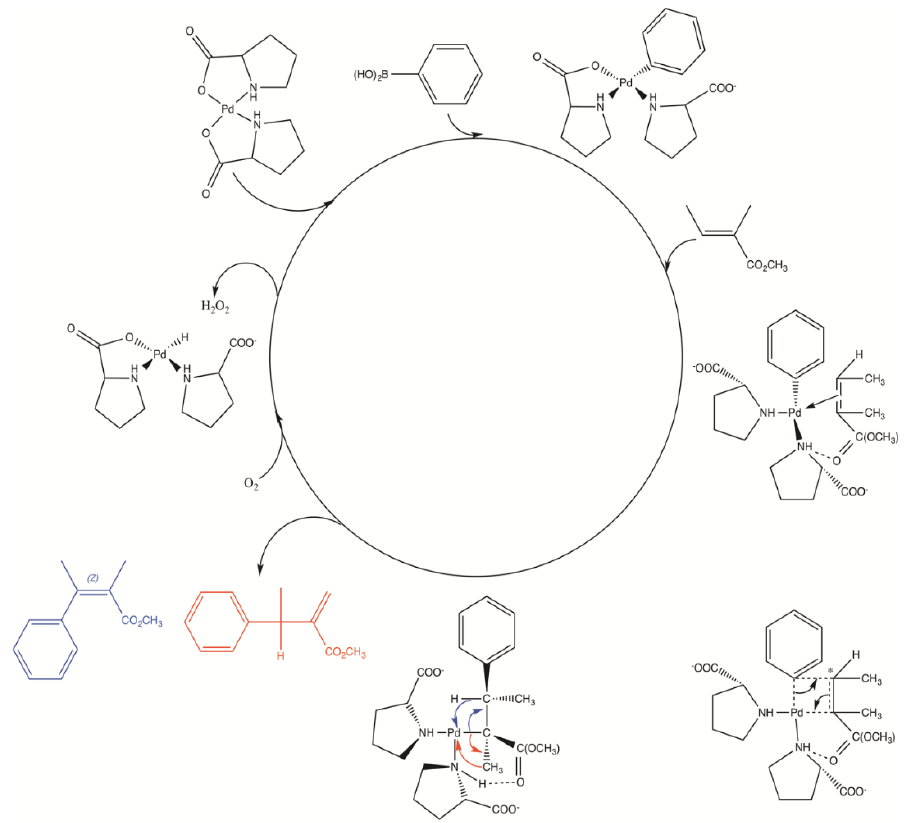
Figure 14. Proposed mechanism of the palladium(II) ‒ amino acid complex catalyzed oxidative coupling of phenylboronic acids to olefins.